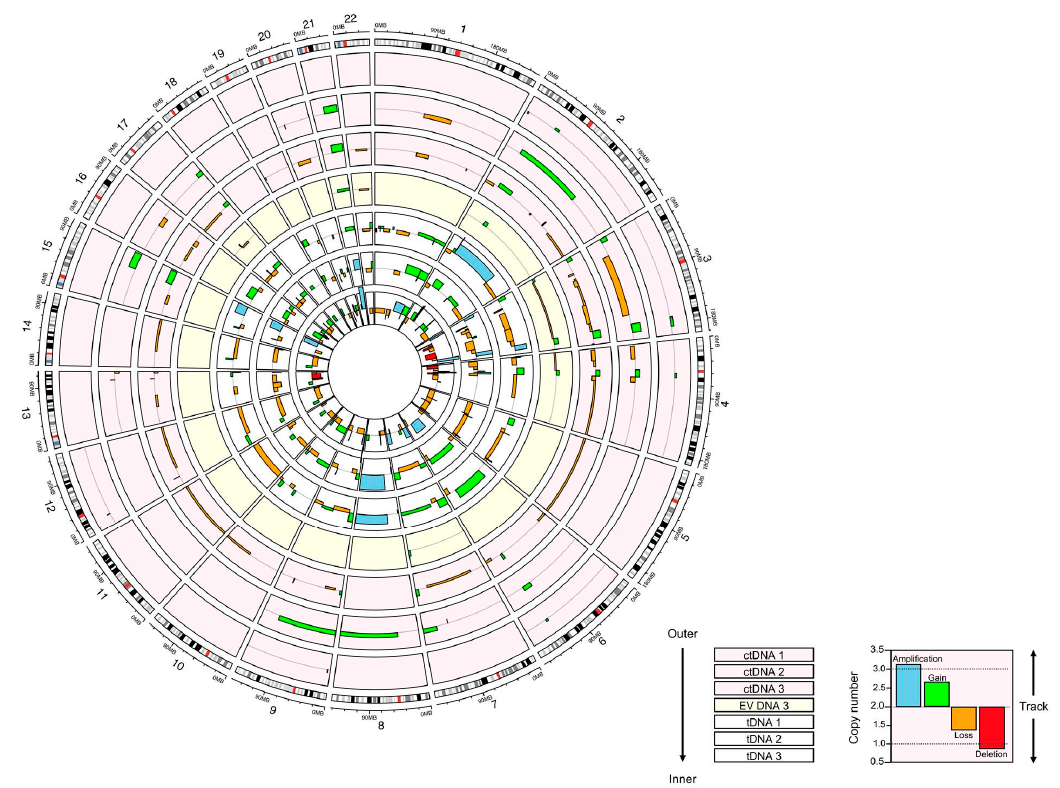
Figure 2. Circos plot comparing copy number alterations detected in ctDNA, EV DNA and tDNA samples. Each track illustrates the copy number across the genome in individual samples. Note that EV DNA samples 1 and 2 did not contain detectable copy number variants (CNVs) and thus are not depicted. Tracks are divided into sections according to each autosome, arranged clockwise from 1 to 22. The vertical scale of the tracks indicates the copy number at that region in the genome. The scale is consistent across all tracks. The grey line in the middle of each track represents a normal copy number of 2.0. CNVs are depicted by boxes coloured according to the type of alteration (see key). The horizontal length of the box indicates the size of the region of altered copy numbers in megabases (scale on outer